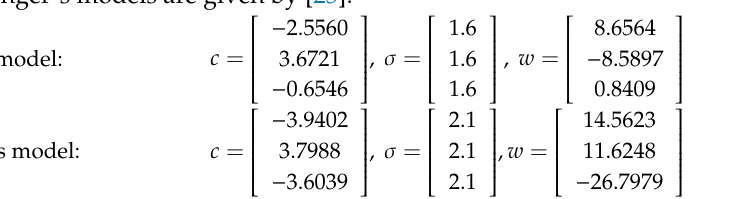
Figure 7. Designated course for data collection experiment.